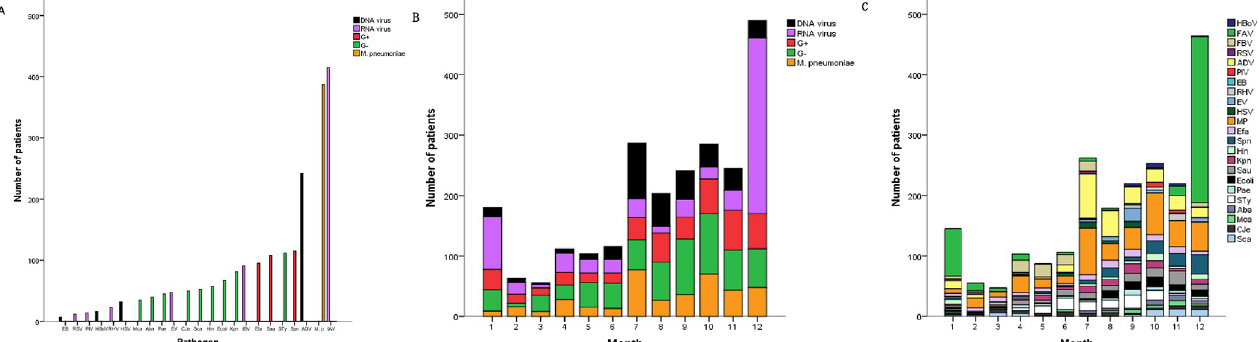
Fig 2. A, Number of patients infected with specific pathogens. B, Distribution of patients infected with DNA viruses, RNA viruses, G+ bacteria, G − bacteria, and M . pneumoniae in 12 months. C, Distribution of specific pathogens in the five groups by the 12 months. The X axis represents the months, and the Y axis represents the number of patients infected with specific pathogens. M . pneumoniae , Mycoplasma pneumoniae group; G+, gram-positive organisms group; G − , gram-negative organism group; HBoV, human Bocavirus; IAV/FAV, influenza A virus; IBV/FBV, influenza B virus; PIV, parainfluenza virus; RHV, rhinovirus; RSV, respiratory syncytial virus; ADV, adenovirus; EBV, Epstein-Barr virus; EV, enterovirus; HSV, herpes simplex virus; Efa, Enterococcus faecium ; Hin, Haemophilus influenzae ; Kpn, Klebsiella pneumoniae ; Sau, Staphylococcus aureus ; E. coli, Escherichia coli ; Spn, Streptococcus Peroris ; Sty, Salmonella typhimurium ; Aba, Acinetobacter baumannii ; Mca, Moraxella catarrhalis ; Cje, Campylobacter Jejuni ; Pae, Pseudomonas aeruginosa ; Sca, Shigella.